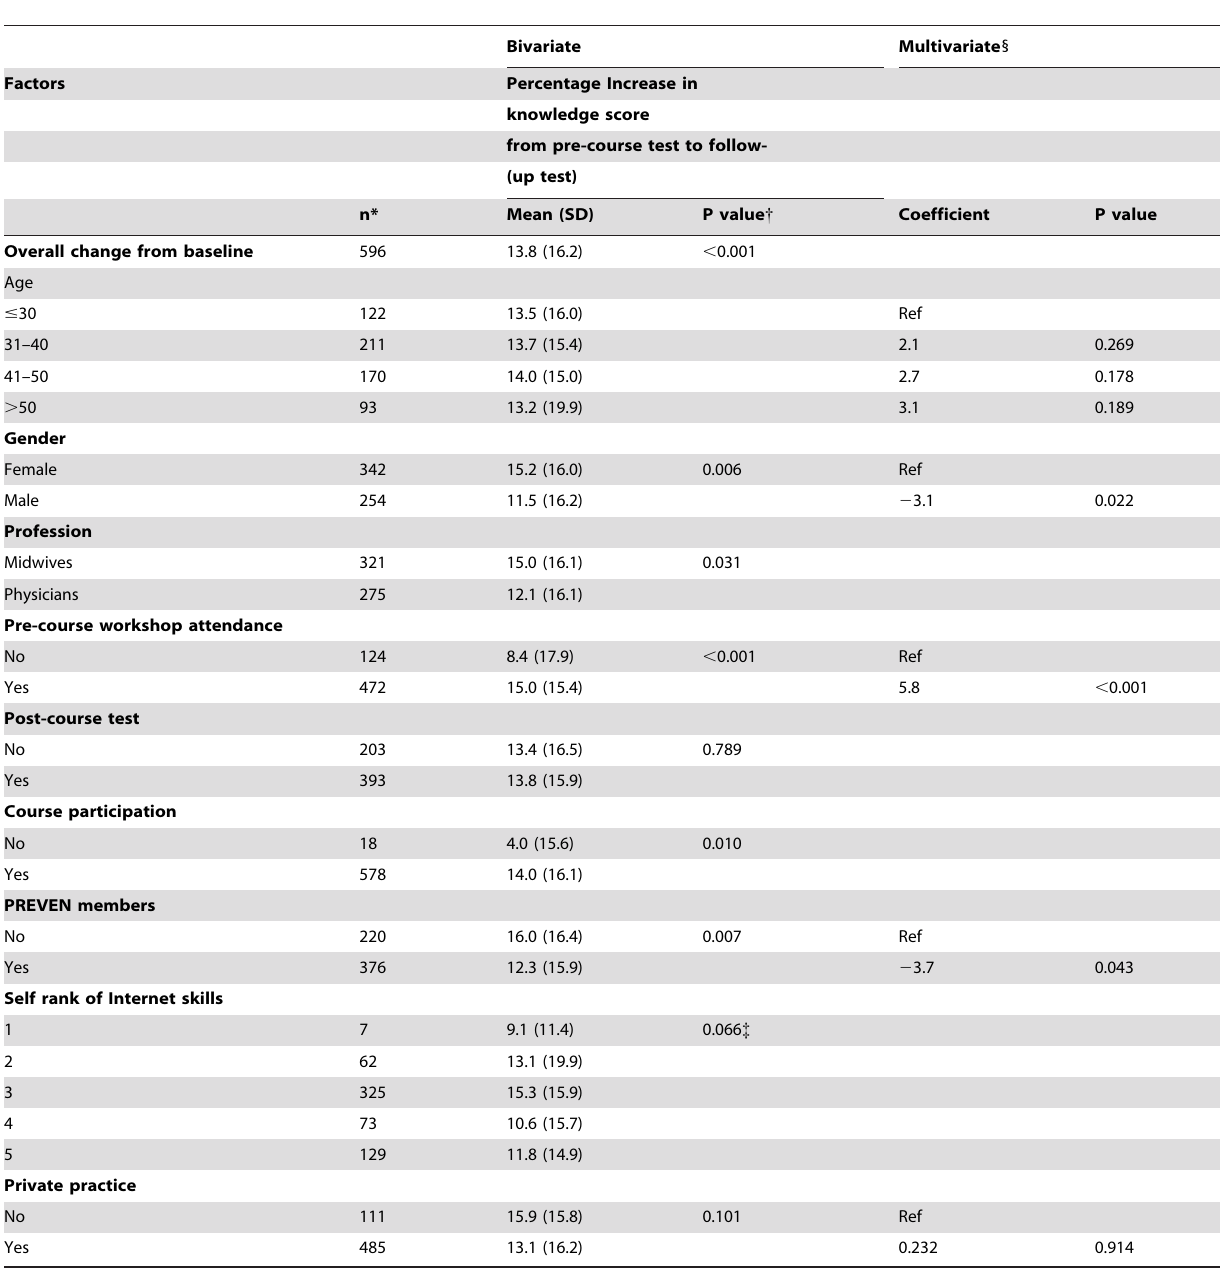
Table 3. Bivariate and multivariate analysis of factors associated with improvements in knowledge of syndromic management of